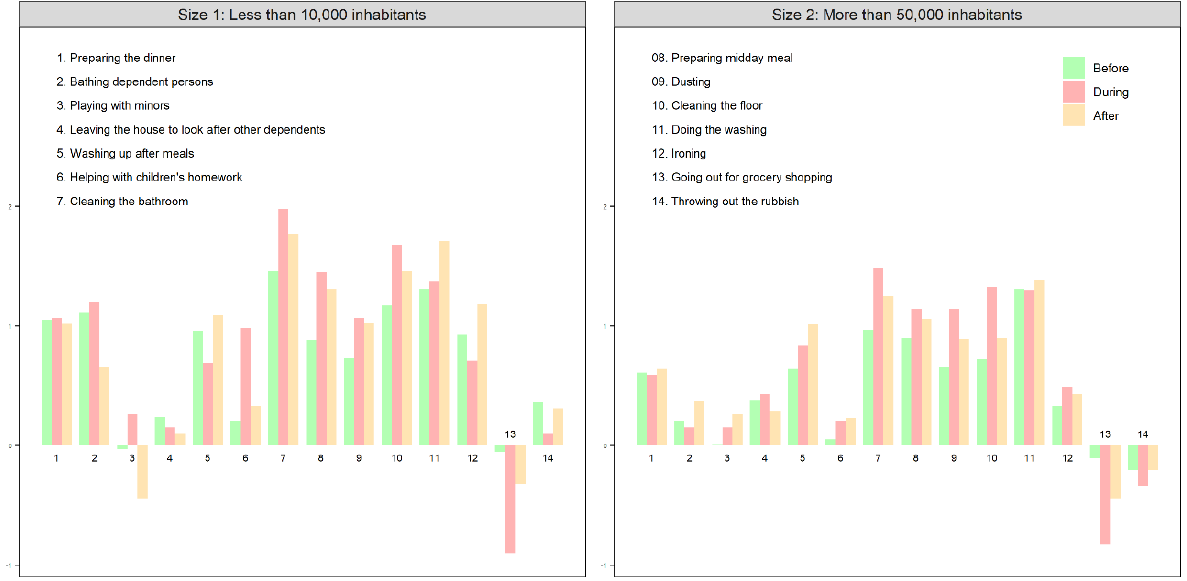
Figure 5. Bar charts of the differences between genders (women–men) in the average number of days per week each household chore is done.